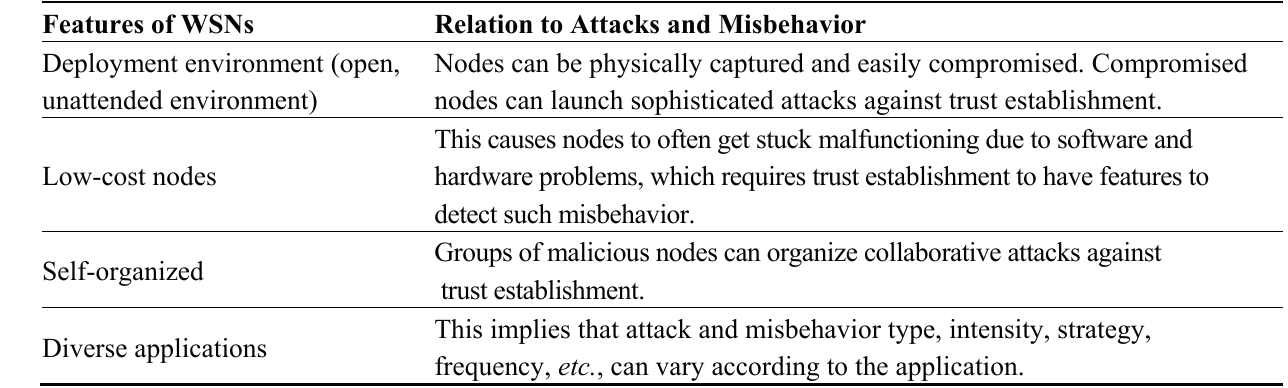
Table 1. Relation between attacks and features of wireless sensor